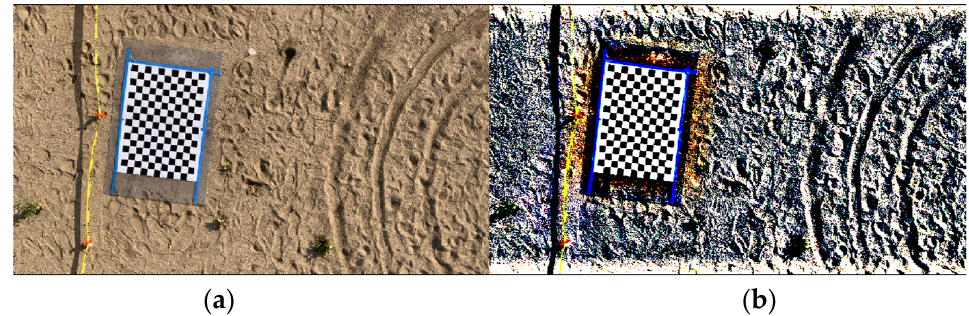
Figure 8. Adjustment of experiment frames before processing them: ( a ) Original frame; ( b ) Adjusted frame.